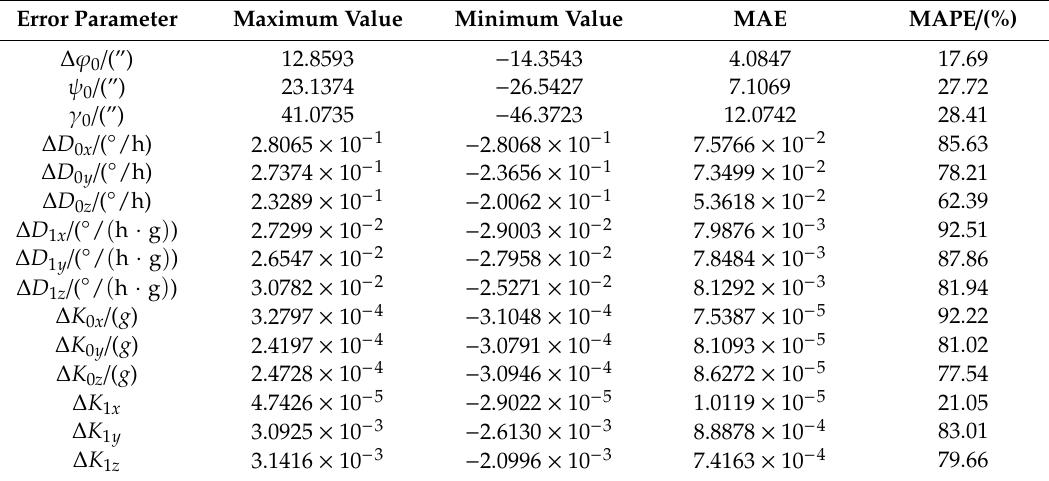
Figure 9. Simulation results of accelerometer residual error using RBM-BPNN method. Table 2. Statistical results of error parameter forecast values using RBM-BPNN